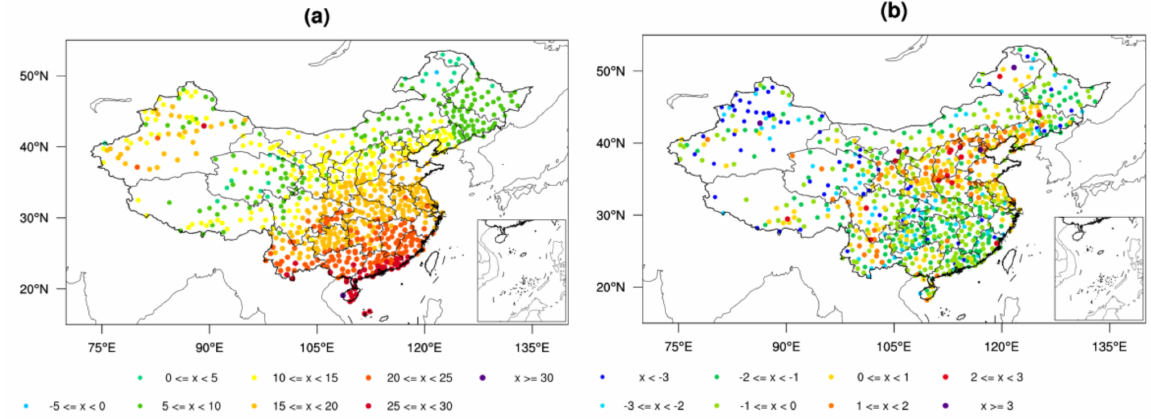
Figure 3. Spatial distributions of the annual averaged ST20 observation ( a ), ST20 ME of CLDAS ( b ), ERA-Interim ( c ), and GLDAS ( d ).